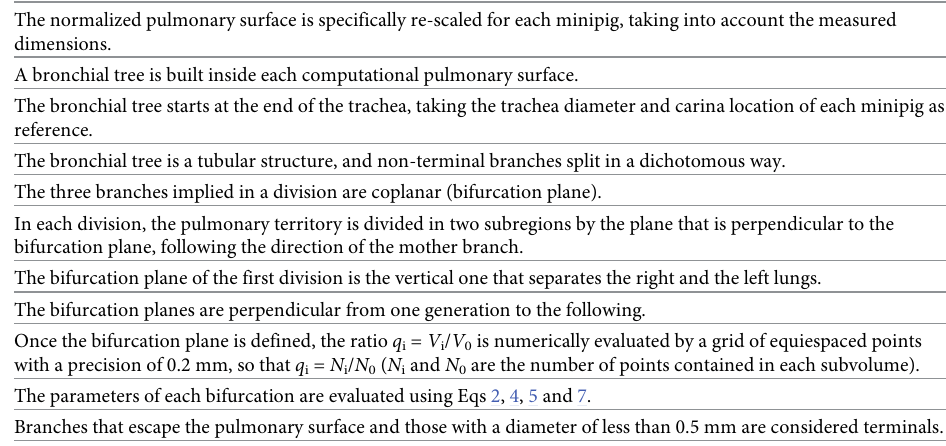
Table 1. Summary of the model for building the computational bronchial tree of each minipig. The normalized pulmonary surface is specifically re-scaled for each minipig, taking into account the measured dimensions. A bronchial tree is built inside each computational pulmonary surface. The bronchial tree starts at the end of the trachea, taking the trachea diameter and carina location of each minipig as reference. The bronchial tree is a tubular structure, and non-terminal branches split in a dichotomous way. The three branches implied in a division are coplanar (bifurcation plane). In each division, the pulmonary territory is divided in two subregions by the plane that is perpendicular to the bifurcation plane, following the direction of the mother branch. The bifurcation plane of the first division is the vertical one that separates the right and the left lungs. The bifurcation planes are perpendicular from one generation to the following. Once the bifurcation plane is defined, the ratio q i = V i / V 0 is numerically evaluated by a grid of equiespaced points with a precision of 0.2 mm, so that q i = N i / N 0 ( N i and N 0 are the number of points contained in each subvolume). The parameters of each bifurcation are evaluated using Eqs 2, 4, 5 and 7. Branches that escape the pulmonary surface and those with a diameter of less than 0.5 mm are considered terminals.